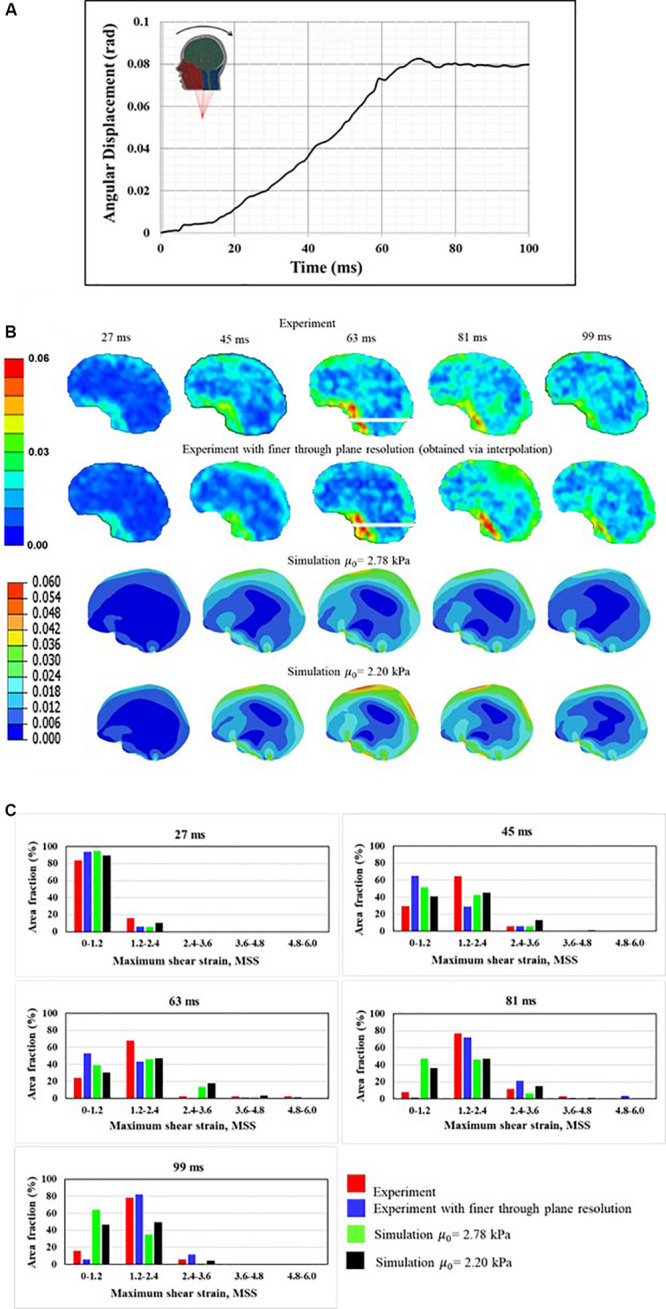
Comparison of human response against experimental data (A) boundary conditions, (B) qualitative comparison, and (C) quantitative comparison. Maximum shear strain, MSS measure is used for qualitative and quantitative companions.